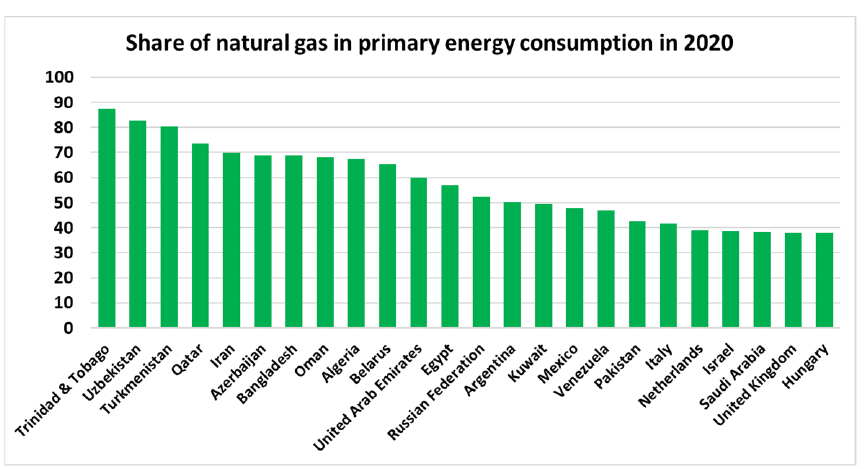
Figure 7. Countries in which the shares of natural gas in primary energy consumption are the largest in 2020, % [5].